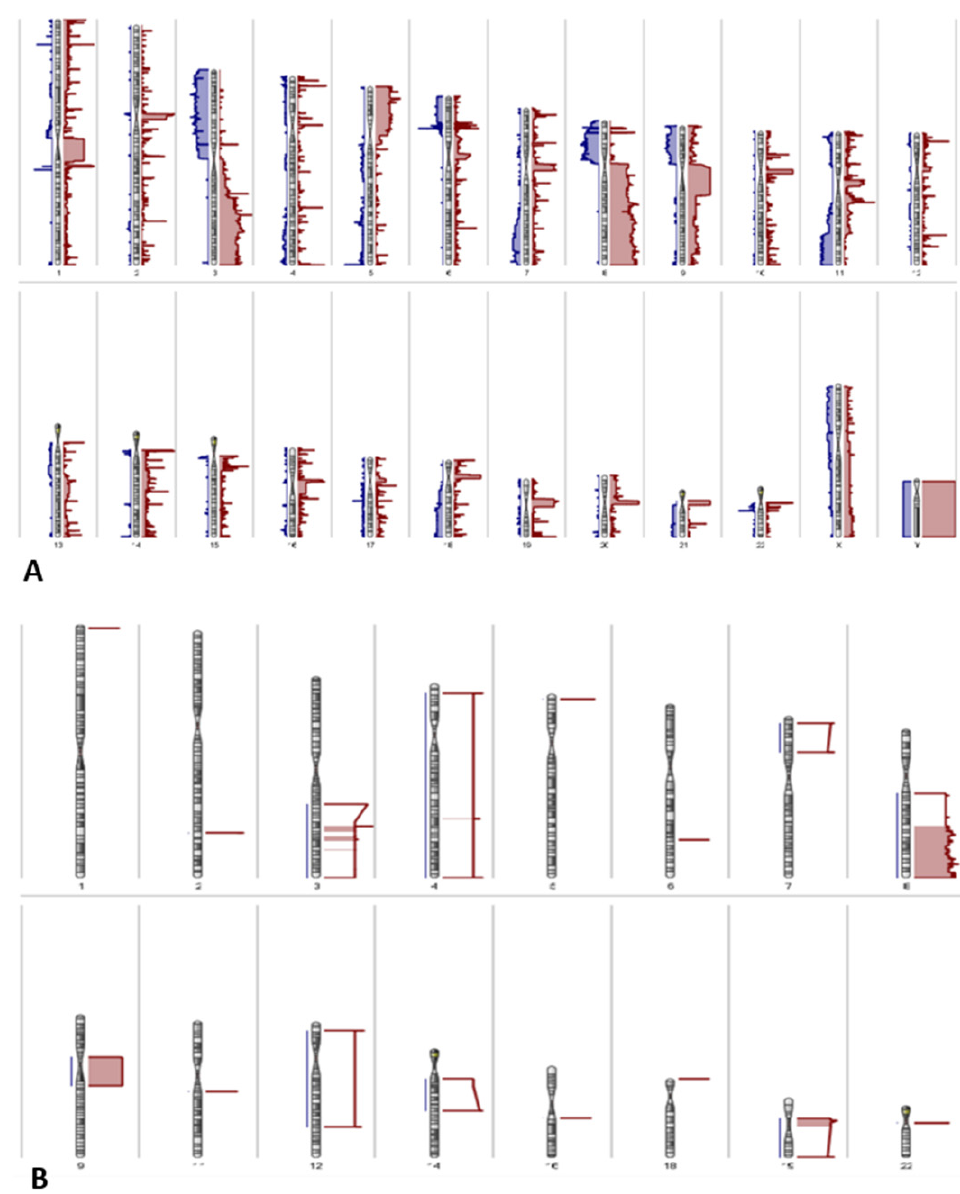
Figure 4. Karyogram depicting the amplifications (red) and deletions (blue) detected in ( A ) all VSCC samples, frequent amplifications in VSCC, ( B ) in >50% of VSCC samples.